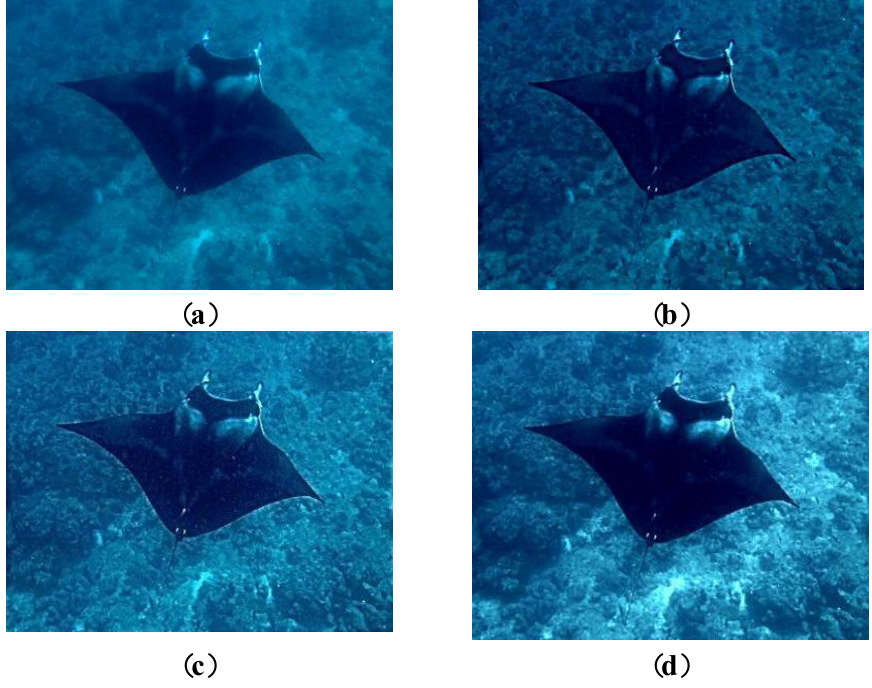
Figure 6. Image quality enhancement. ( a ) Original image. ( b ) Wavelet filtering. ( c ) Homomorphic filtering. ( d ) Image enhancement